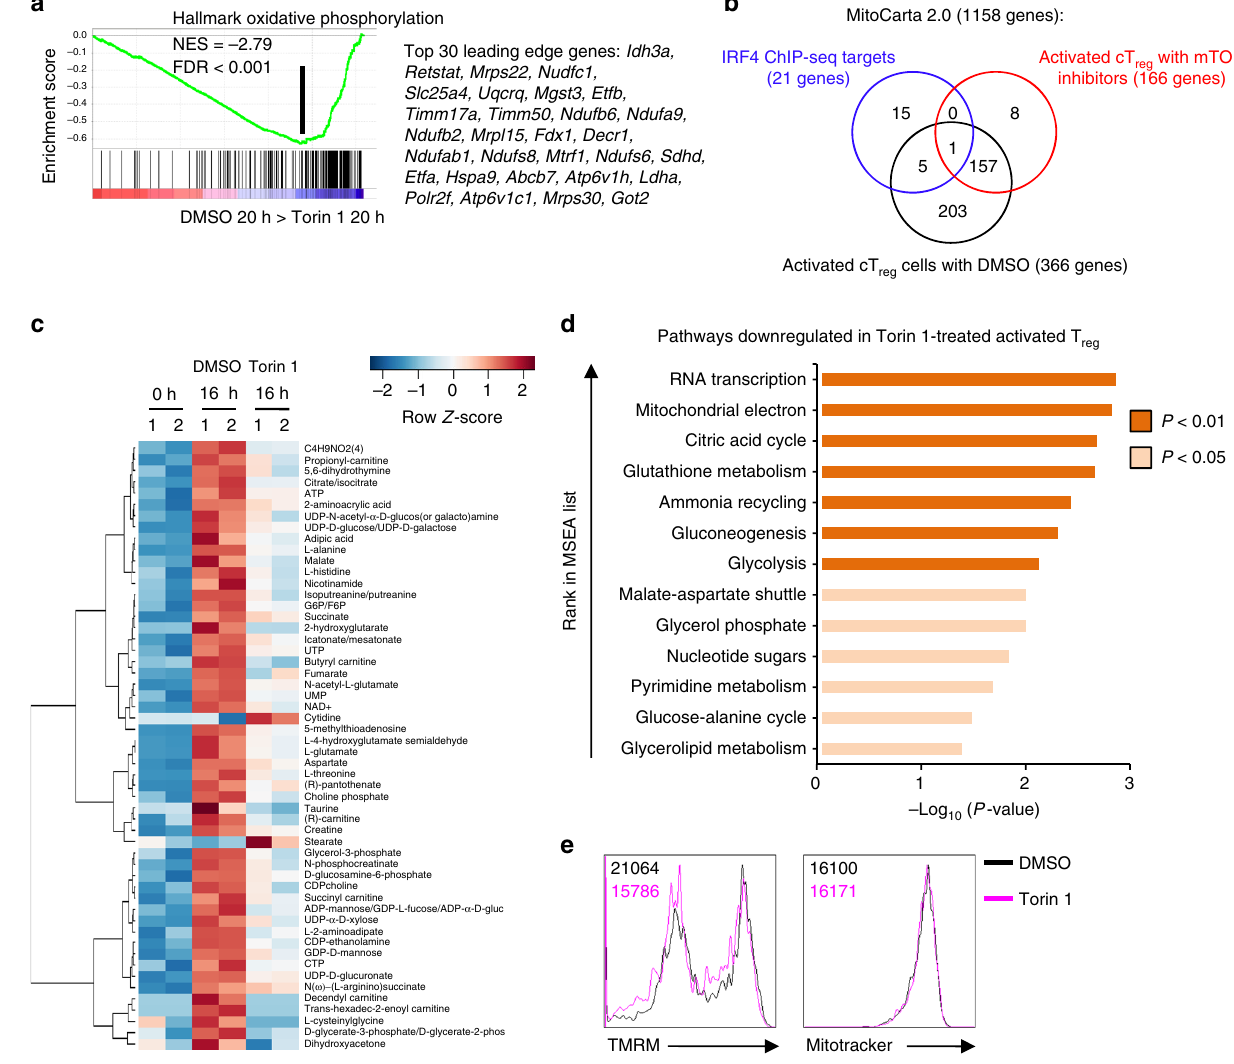
Fig. 7 mTOR controls metabolic reprogramming upon T reg -cell activation. a Enrichment plot of the Hallmark oxidative phosphorylation pathway in cT reg cells activated for 20 h in the presence of either Torin 1 or DMSO control, identi fi ed by gene set enrichment analysis (GSEA). The top 30 enriched genes (position indicated by the vertical black line) are listed. b Venn-diagram depicting mitochondria-related genes (de fi ned in MitoCarta 2.0 database) that are IRF4 targets (blue circle), or differentially expressed in activated cT reg cells (vs. unstimulated cells; black circle) or activated cT reg cells treated with mTOR inhibitors (vs. those treated with DMSO; red circle). The numbers indicate the shared and independent genes in each category. c Heat map of differentially expressed intracellular metabolites in freshly isolated T reg cells or T reg cells activated for 16 h in the presence of DMSO or Torin 1. d Metabolite set enrichment analysis (MSEA) of KEGG metabolic pathways downregulated in Torin 1-treated activated T reg cells compared to vehicle-treated activated T reg cells. e Flow cytometry of TMRM and Mitotracker staining in T reg cells activated for 20 h in the presence of Torin 1 or vehicle control. Data are representative of three (Mitotracker) or four (TMRM) biological replicates from two (Mitotracker) or three (TMRM)